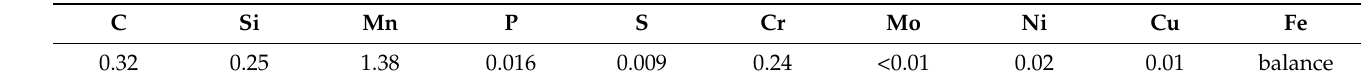
Table 1. Chemical composition of carbon steel (wt. %)